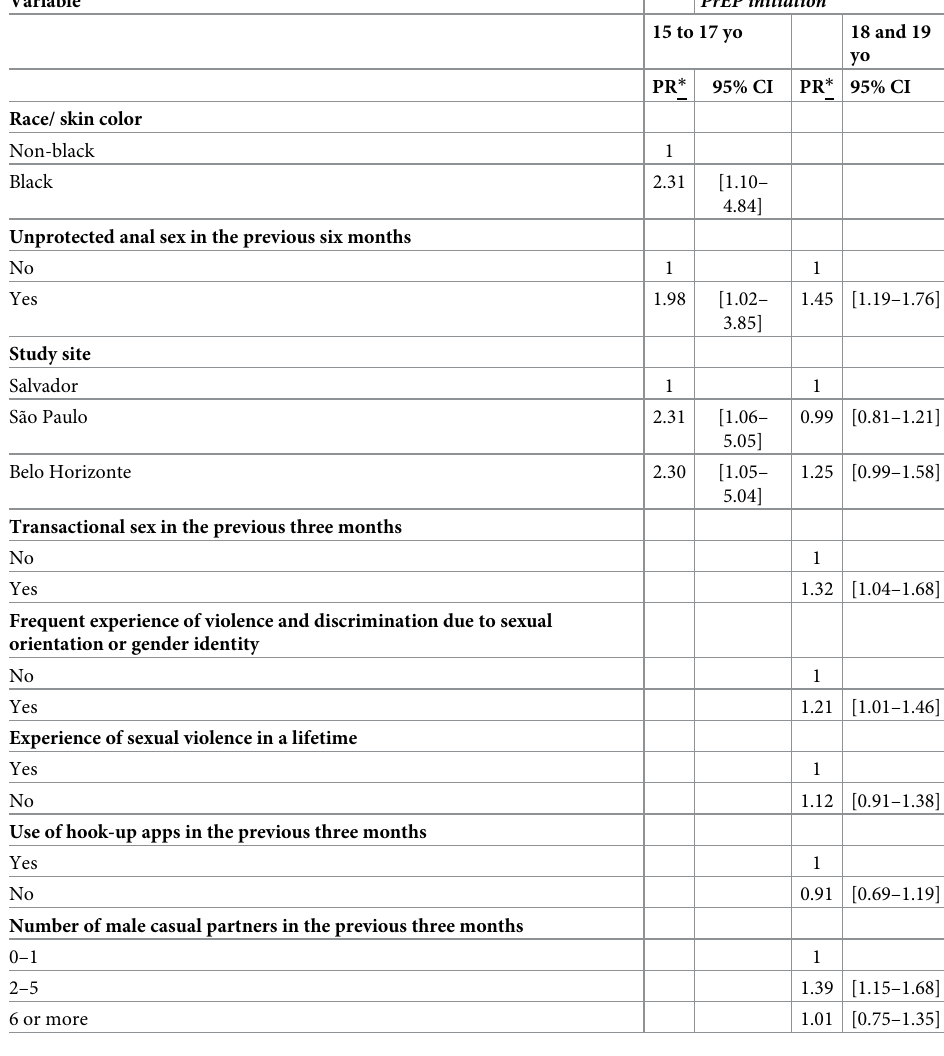
Table 3. Multivariate analysis of PrEP initiation among adolescent MSM and TGW enrolled in the PrEP1519 cohort. February 2019—February